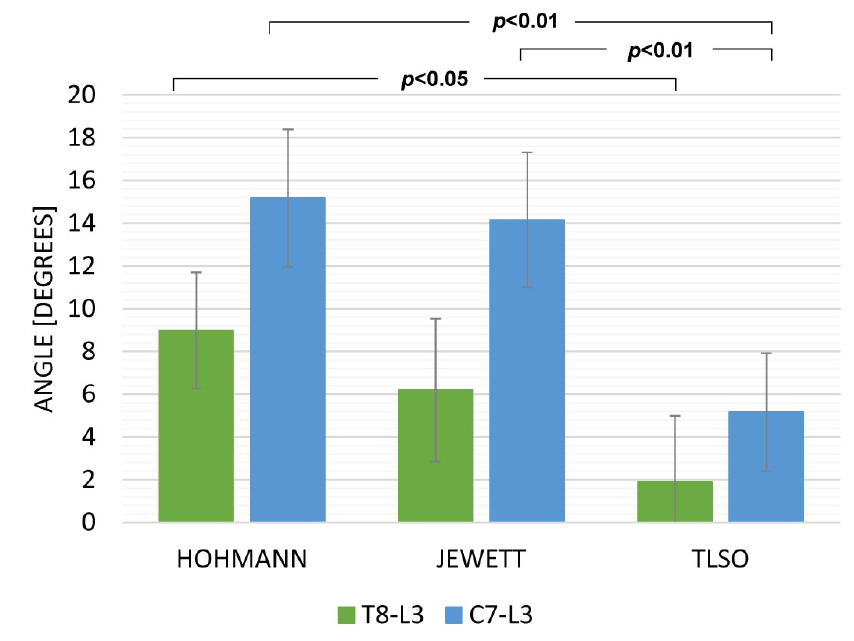
Figure 3. The maximum sagittal inclination during sitting.